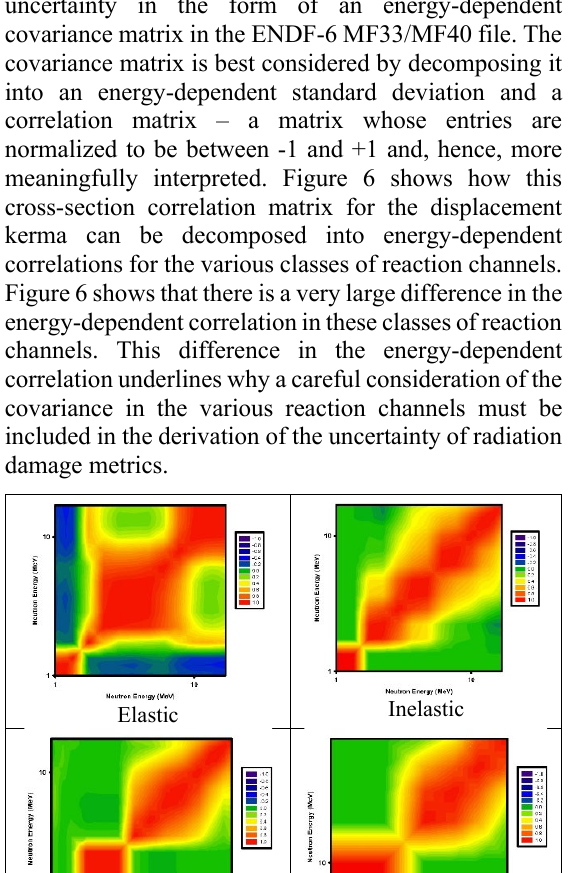
Table 1. Uncertainty contributions from the nuclear data for 28 Si damage metrics in the 252 Cf(s.f.) neutron